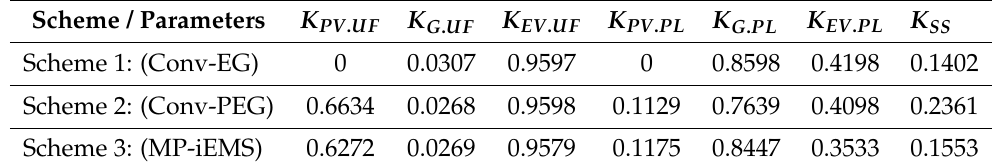
Table 4. Comparison of ESEs utilization factor (UF) and penetration level (PL) for various schemes. Scheme /